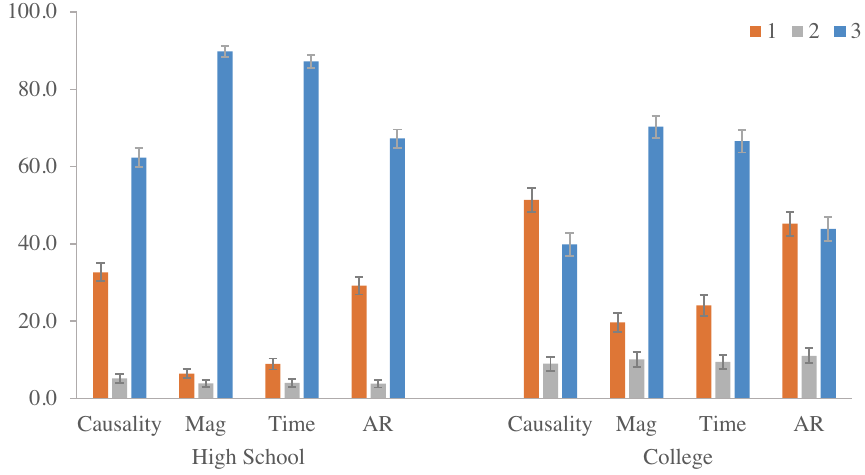
FIG. 2. Average percentages of high school and college students ’ answers on the four attributes of causal reasoning including causality, magnitude (Mag), time, and the action-reaction language (AR). The error bars reflect the